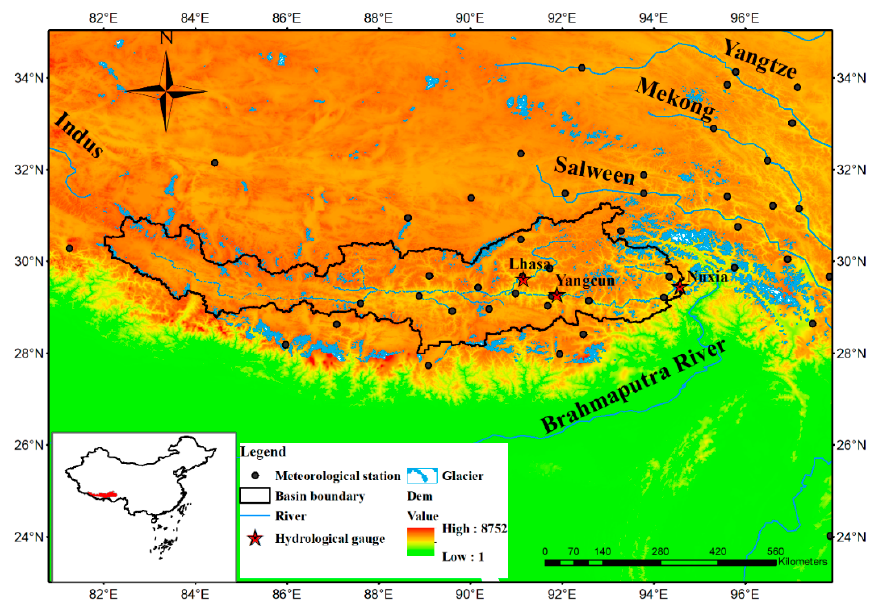
Figure 1. Location and topography of the Upper Brahmaputra River Basin. The black solid dots denote the meteorological stations.